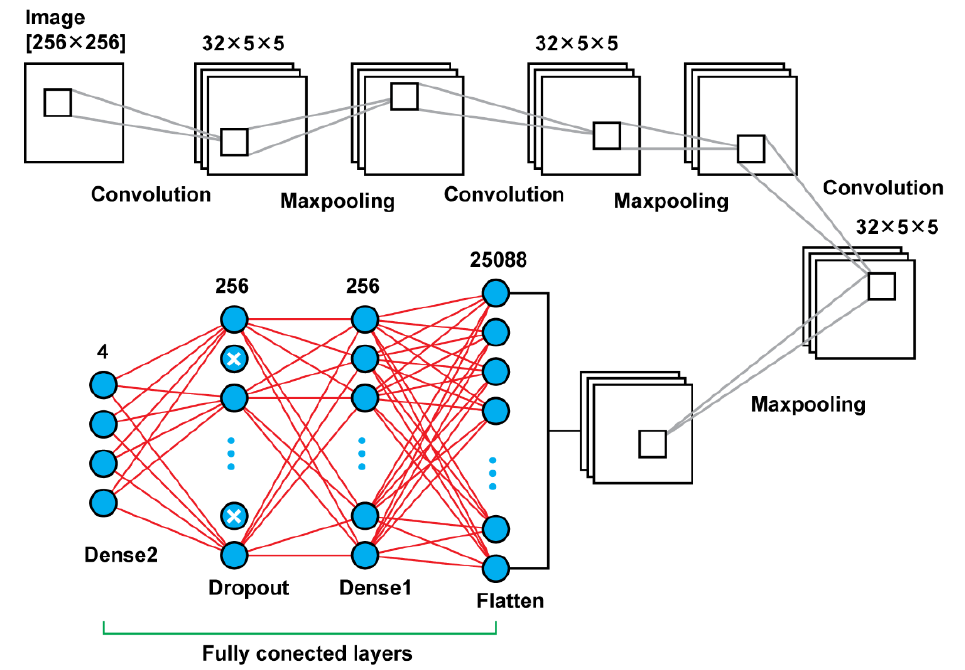
Figure 5. Model 3 architecture. Table 3. Model 3 summary. Table 3. Model 3